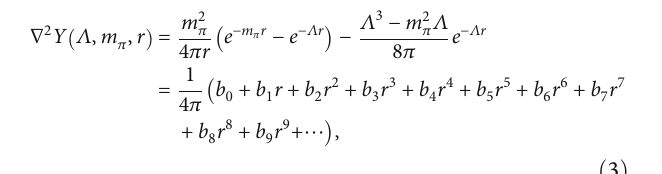
ð MeV Þ , M ð MeV ÞÞ for P B P c